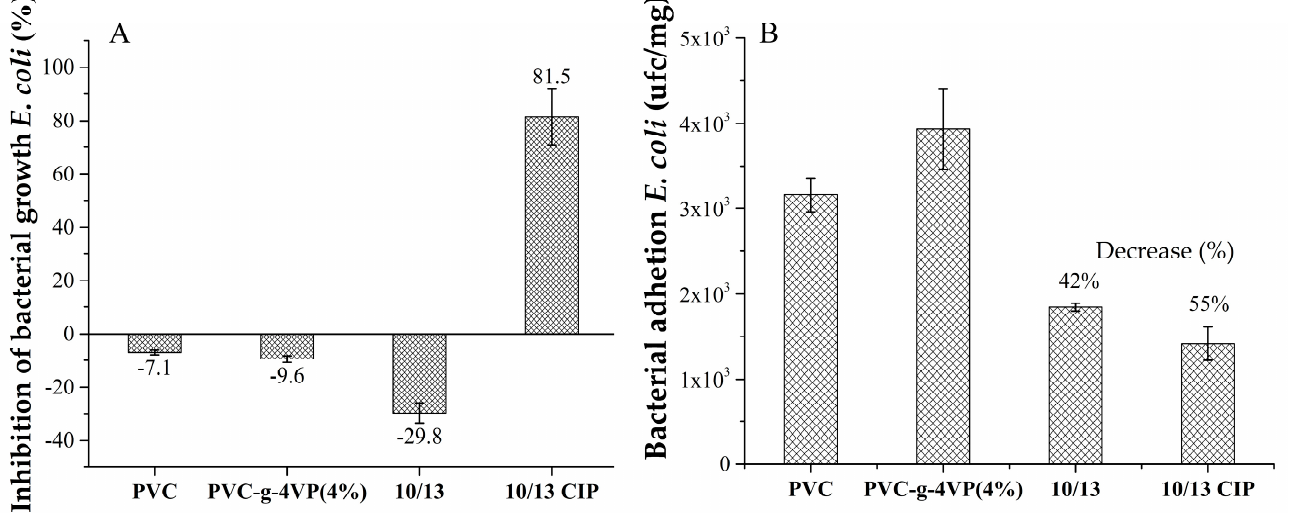
Figure 10. ( A ) Inhibition of bacterial growth for E. coli and ( B ) Bacterial adhesion of E. coli. Reported: mean ± standard error of the mean, n = 3.